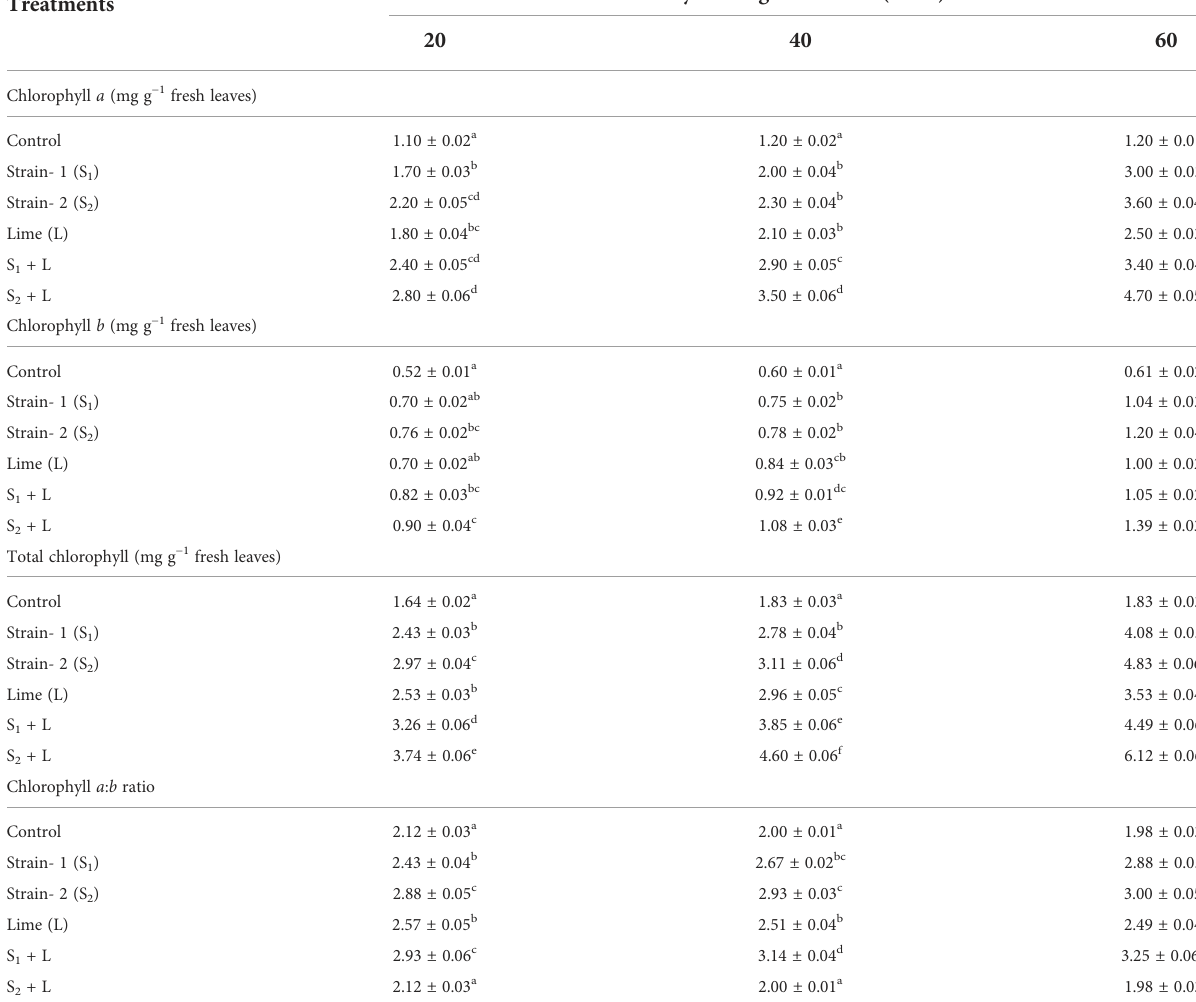
TABLE 1 In fl uence of Rhizobium strains on photosynthetic activity of French bean crop. Treatments